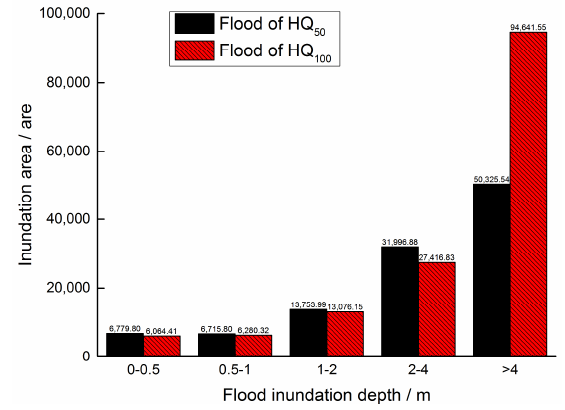
Figure 12. Flood inundation area of different return periods.